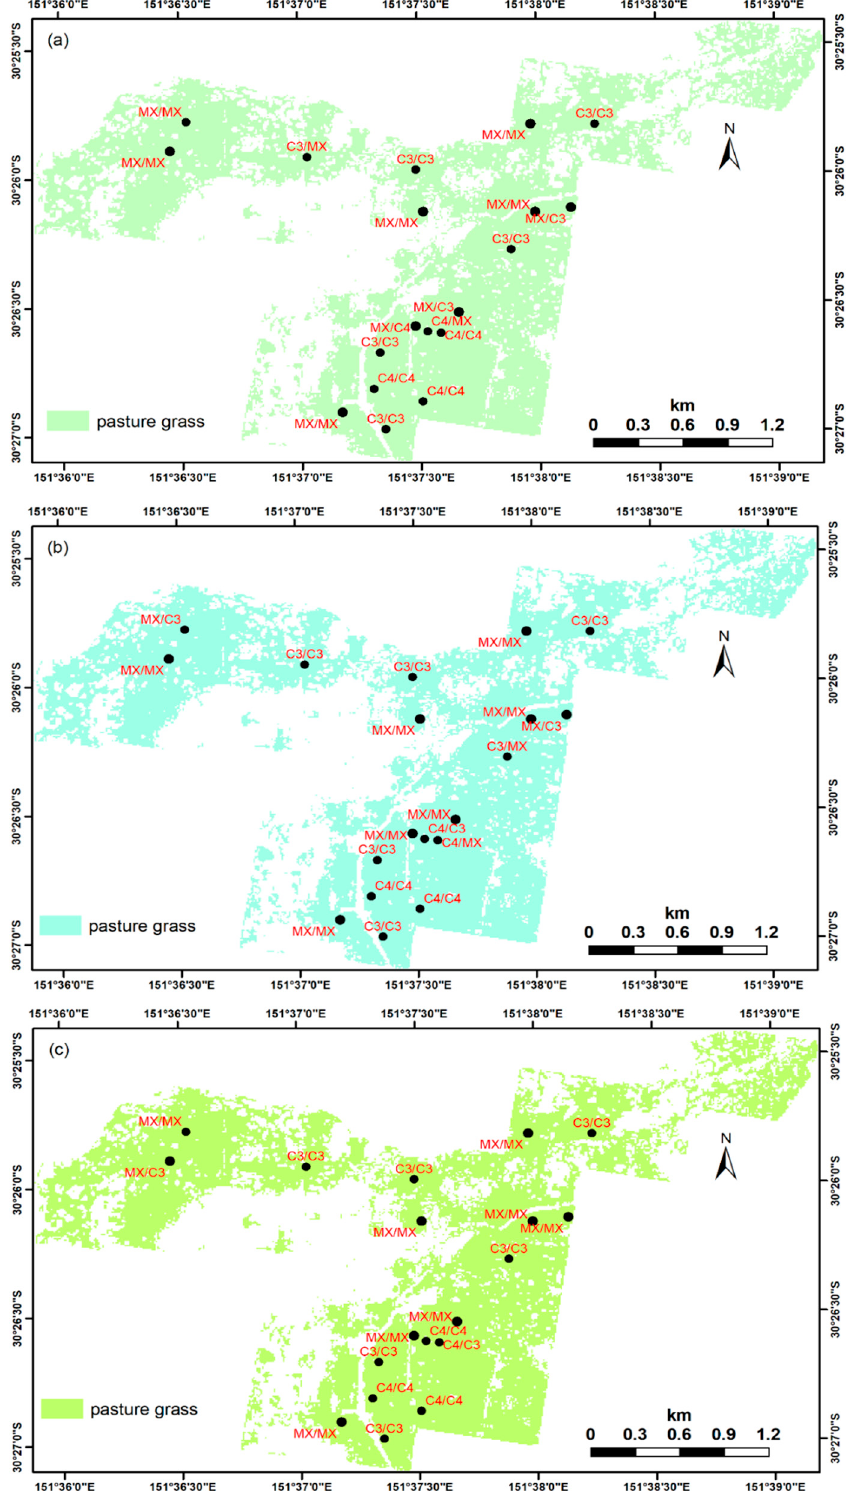
Figure 5. Spatial characterization of the predictive performance of random forest models using different features including ( a ) polarimetric SAR features (polSAR), ( b ) grey-level co-occurrence matrix textural features (glcmTEX), and ( c ) combination of polSAR and glcmTEX features (COMB). This result is just a subset of the 1080 observations in order to preserve the clarity of the maps. The dark circles denote sampling sites with the red texts showing the pasture class observed on the field against the model predicted class (i.e., observed class/predicted class).